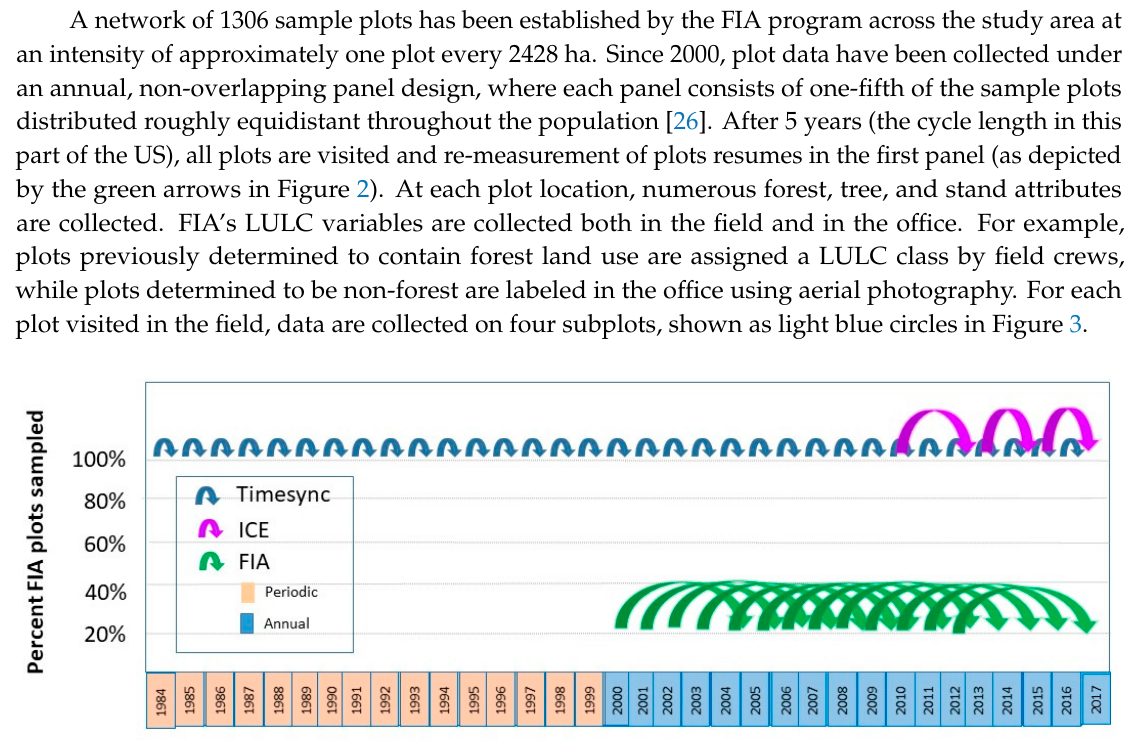
Figure 2. The percentage of plots in FIA’s quasi-systematic grid that were sampled under each of the three land use and land cover change observation systems by year pairings. Percentages on the y -axis indicate the proportion of the population sampled at each time step ( x -axis). Older periodic inventories conducted by FIA are not included in these analyses.